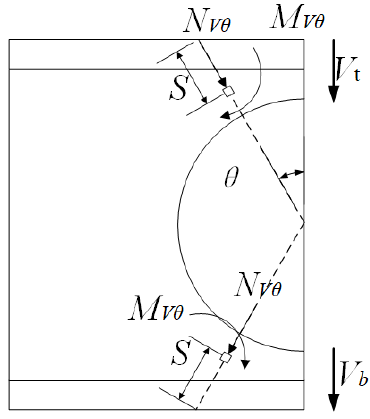
Figure 15. Shear model.